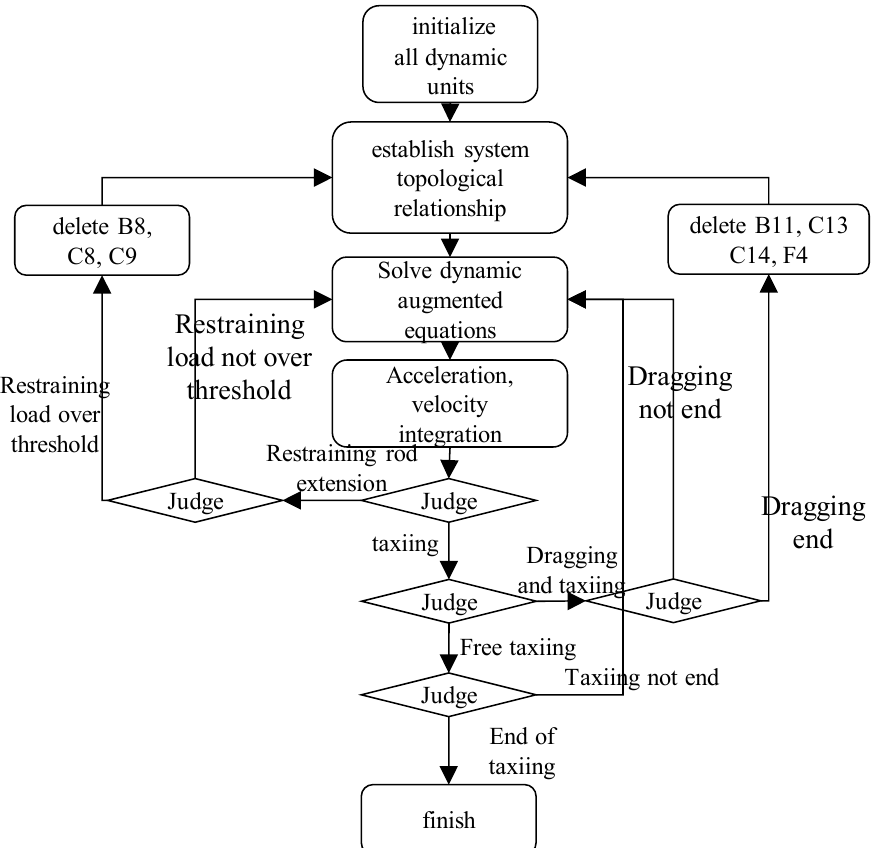
Figure 5. Connection relationships of the front landing structure of a carrier-based aircraft.